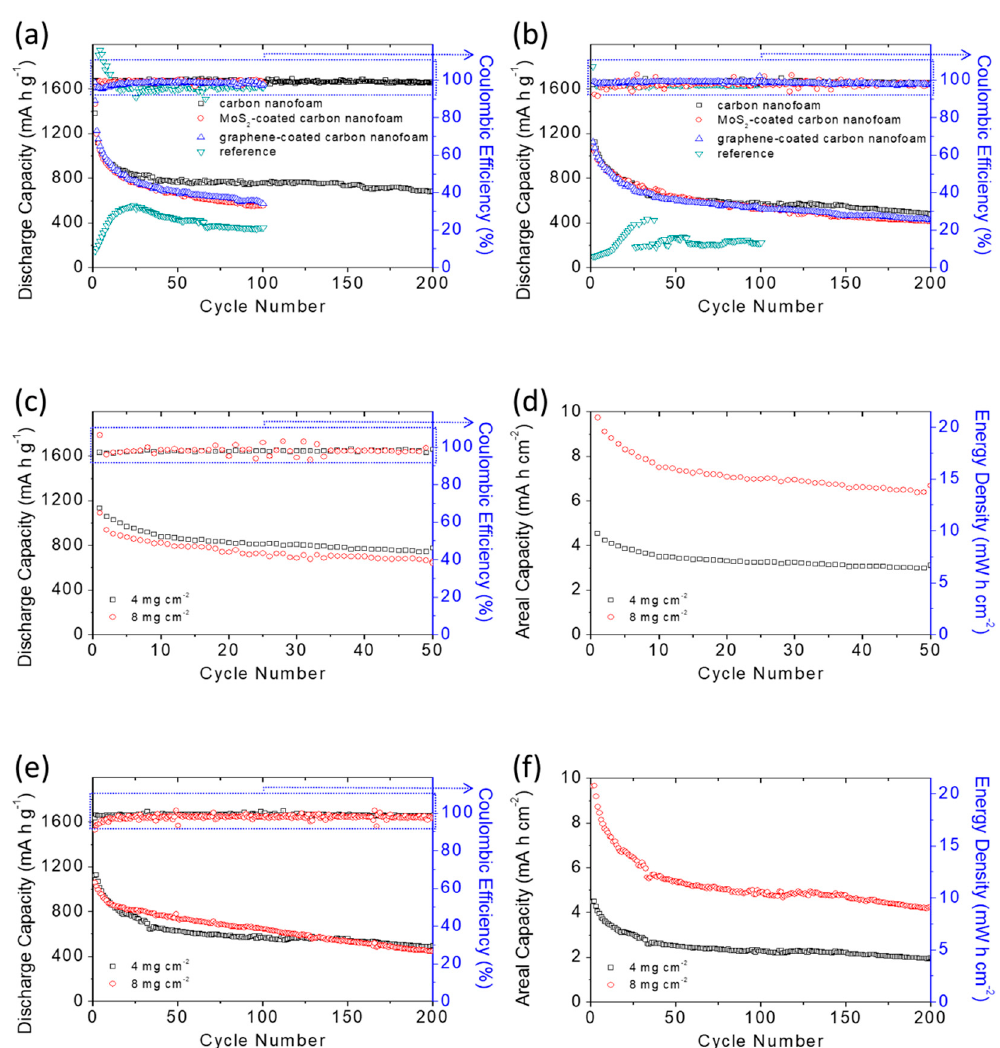
Figure 7. Battery performance analysis: cyclability of the sulfur cathodes with various carbon-nanofoam interlayers at ( a ) the C/20 rate and ( b ) the C/10 rate; battery performance and areal capacity and energy density analysis of the high-loading sulfur cathodes with the carbon-nanofoam interlayer at ( c , d ) the C/20 rate and ( e , f ) the C/10 rate.